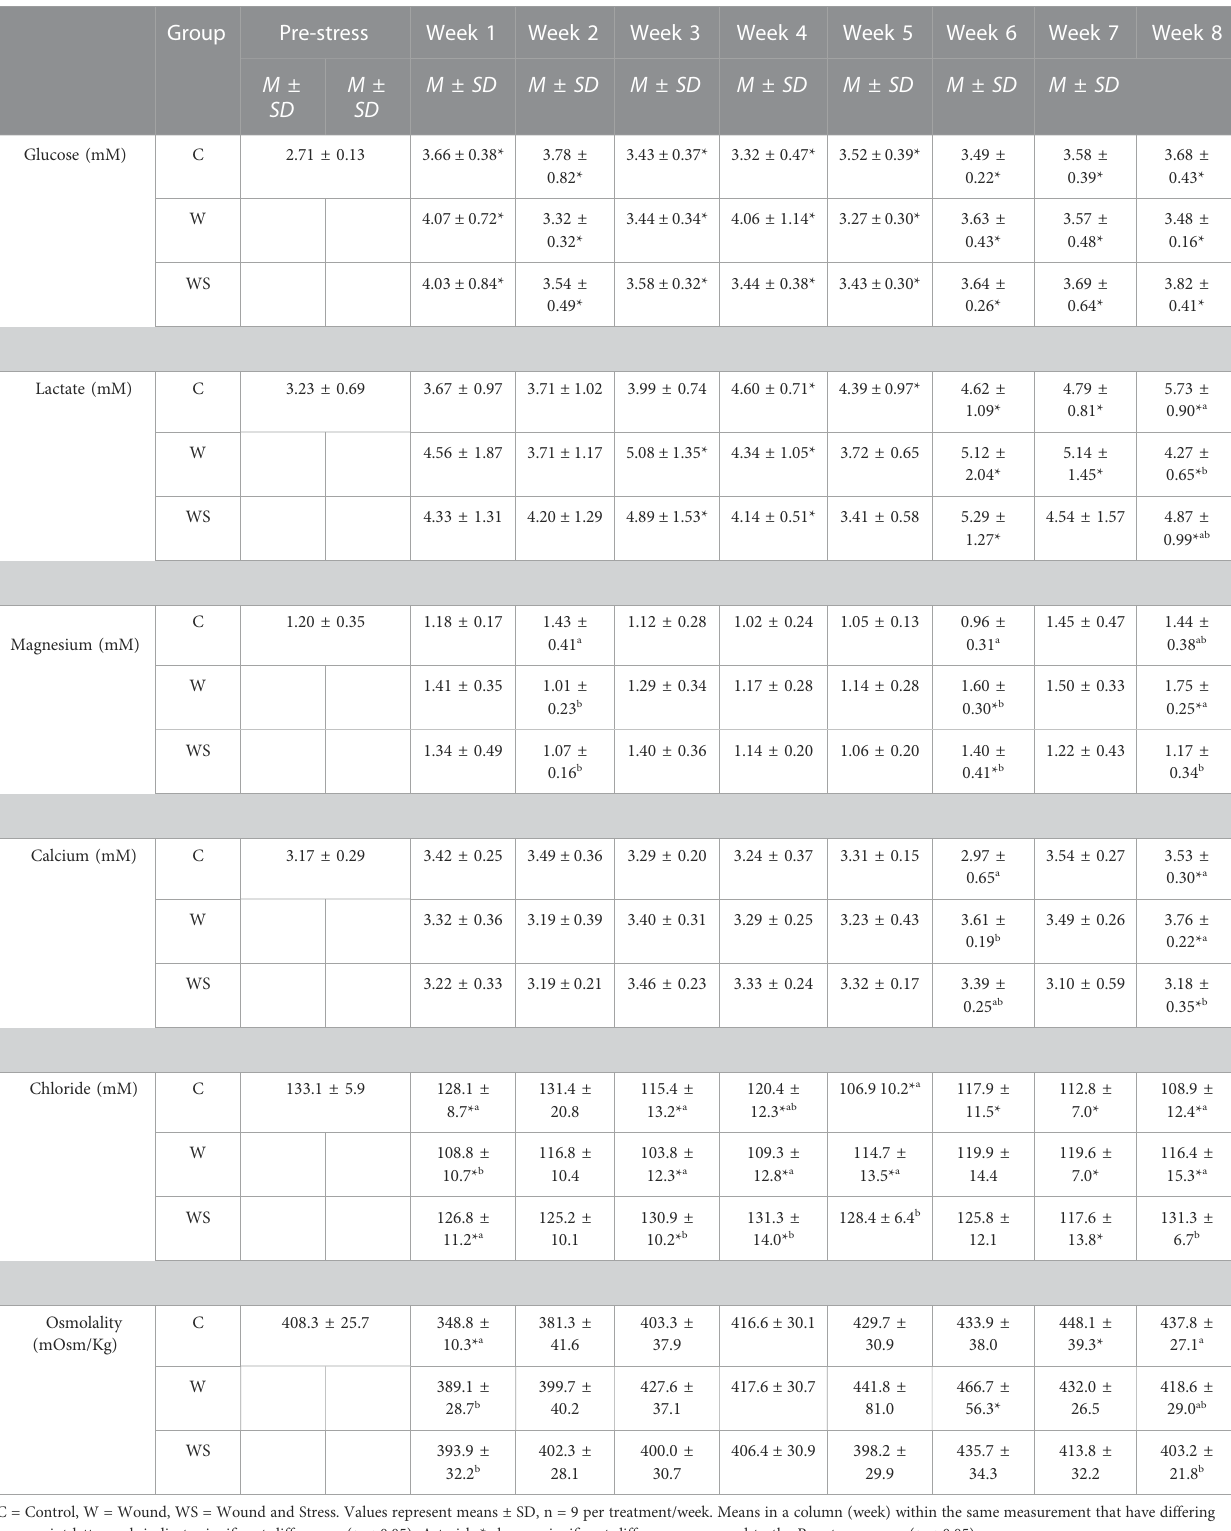
TABLE2Mean ±SD(n=9)of glucose (mM),lactate (mM),magnesium(mM), calcium(mM) andosmolality(mOsm/kg)incontrol(C),wound(W)andwound+stress (WS) during an 8-week experimental timespan (secondary stress